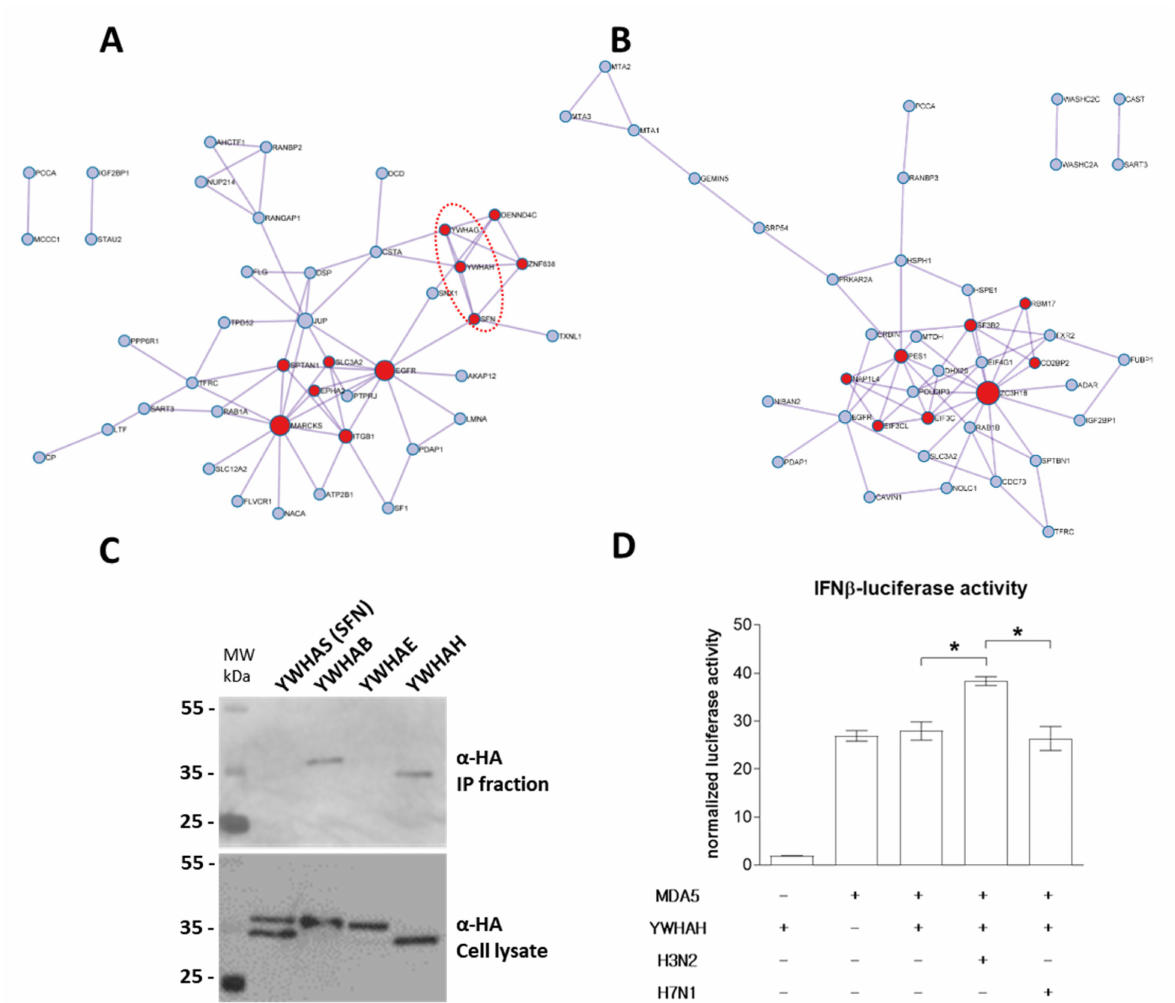
Figure 5. Metascape analysis of PB1-F2 interacting networks. Functional protein–protein interaction network of H3N2 ( A ) and H7N1 PB1-F2 ( B ) are represented. Red nodes represent proteins implicated in “Signaling by Rho GTPases” and in “ribonucleoprotein complex biogenesis” in H3N2 ( A ) and H7N1 ( B ) networks, respectively. The proteins surrounded by a dotted red ellipse are members of the 14-3-3 protein family ( A ). ( C ) Western blot analysis of the PB1-F2–14-3-3 proteins interaction after immunoprecipitation assay. 293T cells were transiently transfected with constructs allowing the expression of HA-tagged 14-3-3 proteins YWHAS, YWHAB, YWHAE and YWHAH together with H3N2 PB1-F2. Immunoprecipitations (IP) were performed with an anti-PB1-F2 antibody. ( D ) 293T cells were transfected with a plasmid encoding an IFN β -luciferase reporter construct together with MDA5, YWHAH and H3N2 PB1-F2 or H7N1 PB1-F2 expressing plasmids. Twenty-four hours